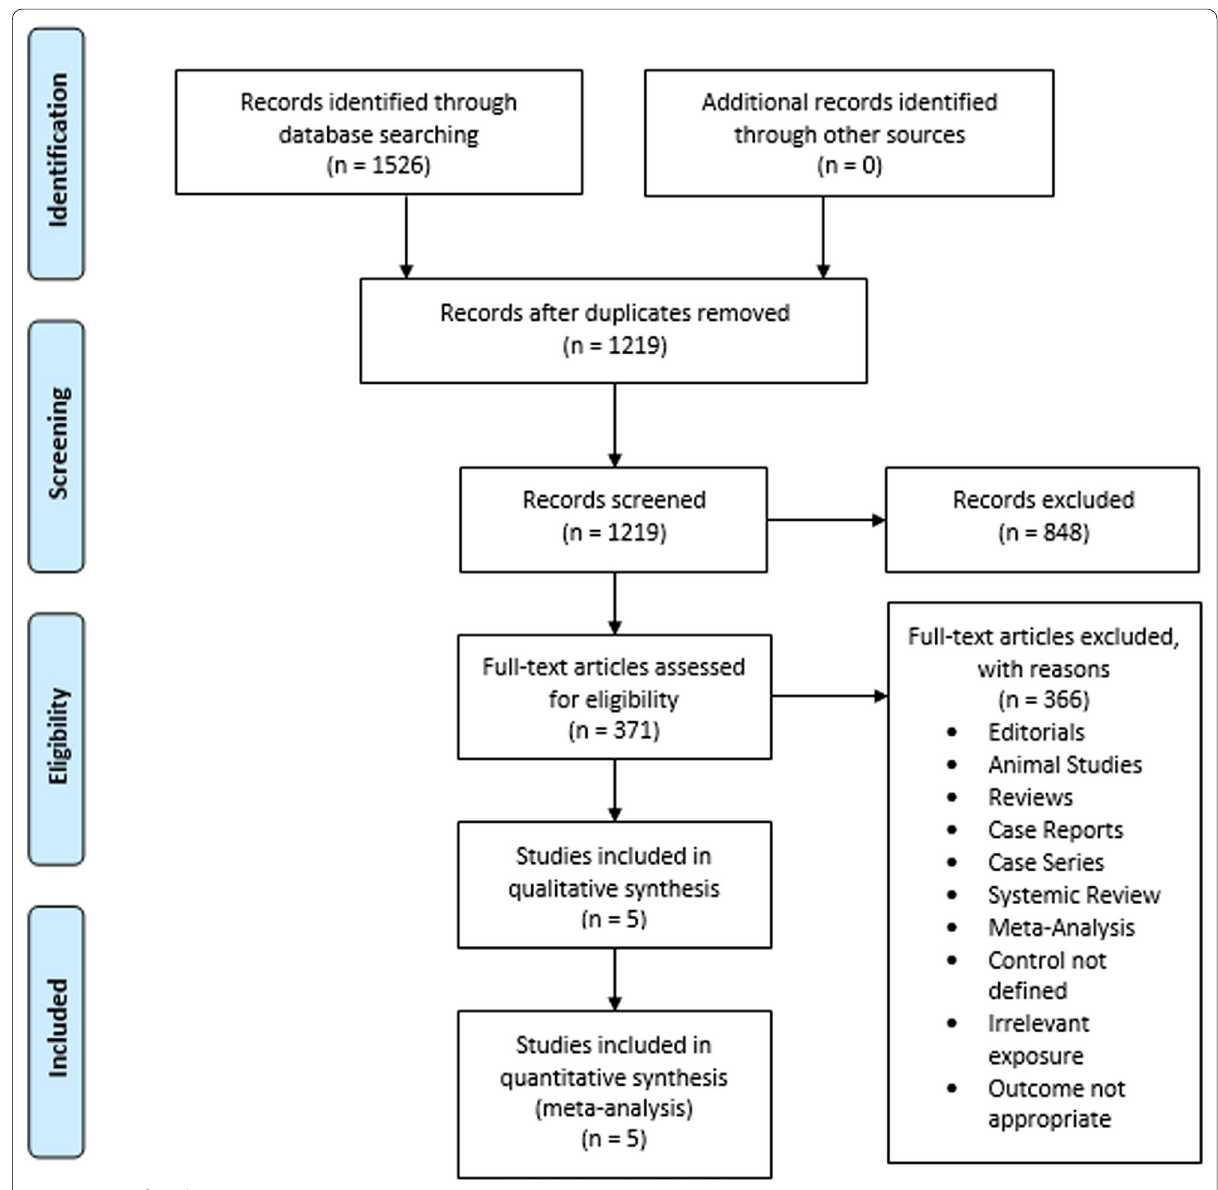
Table 1 Basic characteristics of selected articles